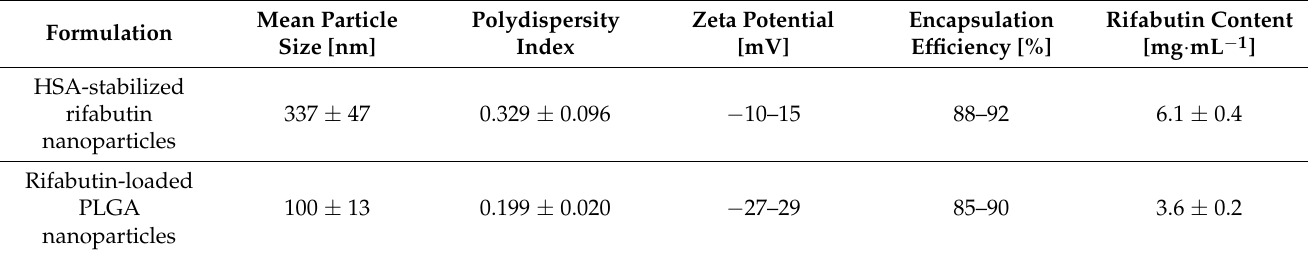
Table 1. Physicochemical parameters of rifabutin formulation prototypes.